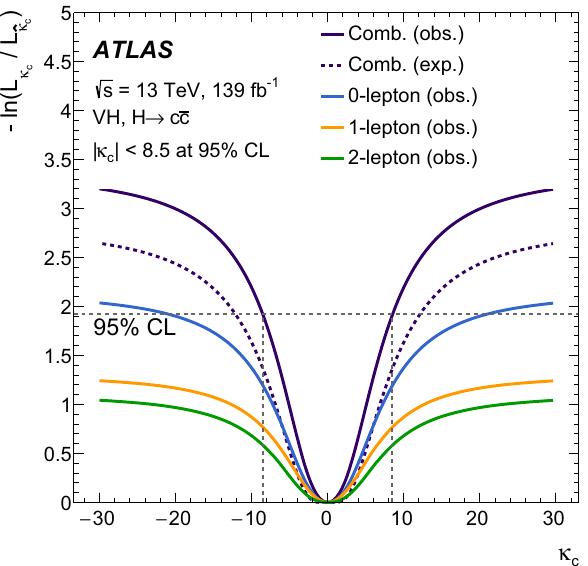
Fig. 4 Expected and observed values of the negative profile log- likelihood ratio as a function of κ c . The single-channel likelihoods are obtained using a five-POI fit, in which each channel has a separate V H ( → c ¯ c ) parameter of interest. The order of the lines in the plot matches the order of the lines in the legend